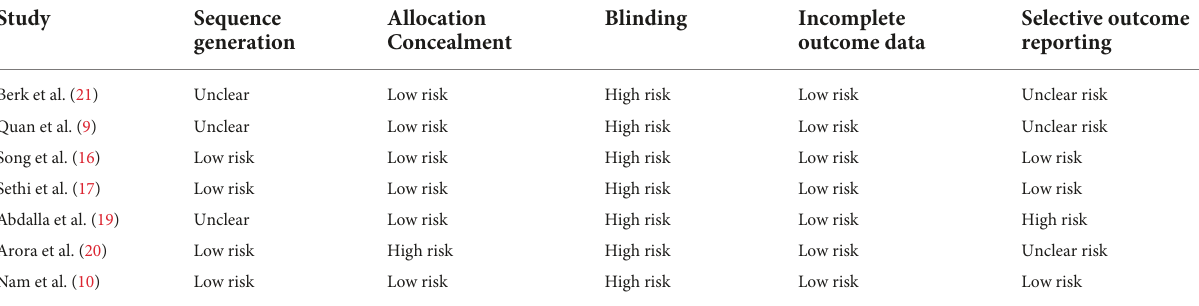
TABLE 2 Assessment of risk of bias and methodological quality of the included studies based on the Cochrane Collaboration’s tool.